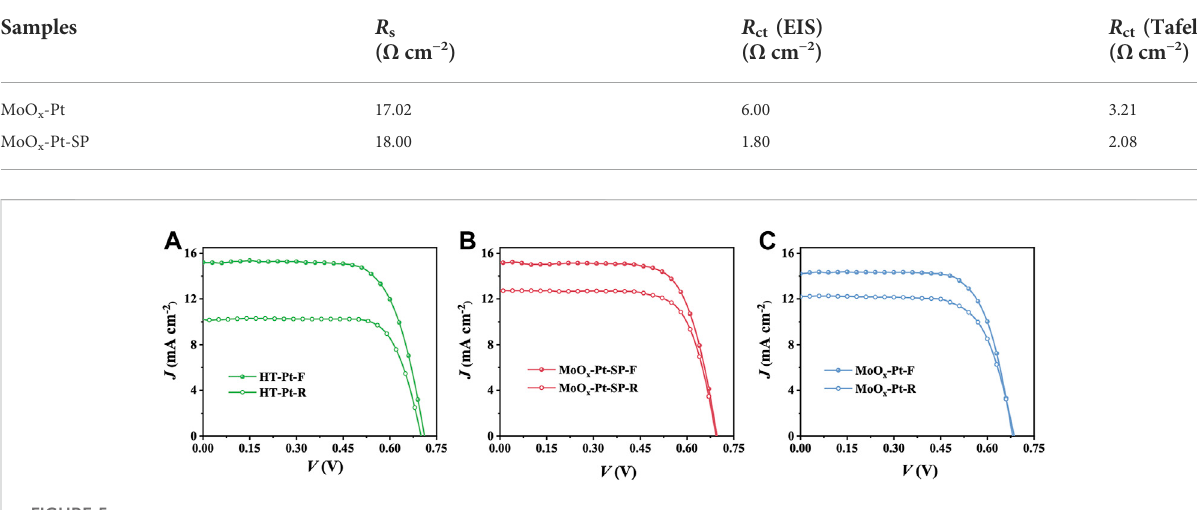
TABLE 2 Summary of R s and R ct fi tted from EIS and Tafel polarization curves of MoO x -Pt and MoO x -Pt-SP CEs. Samples